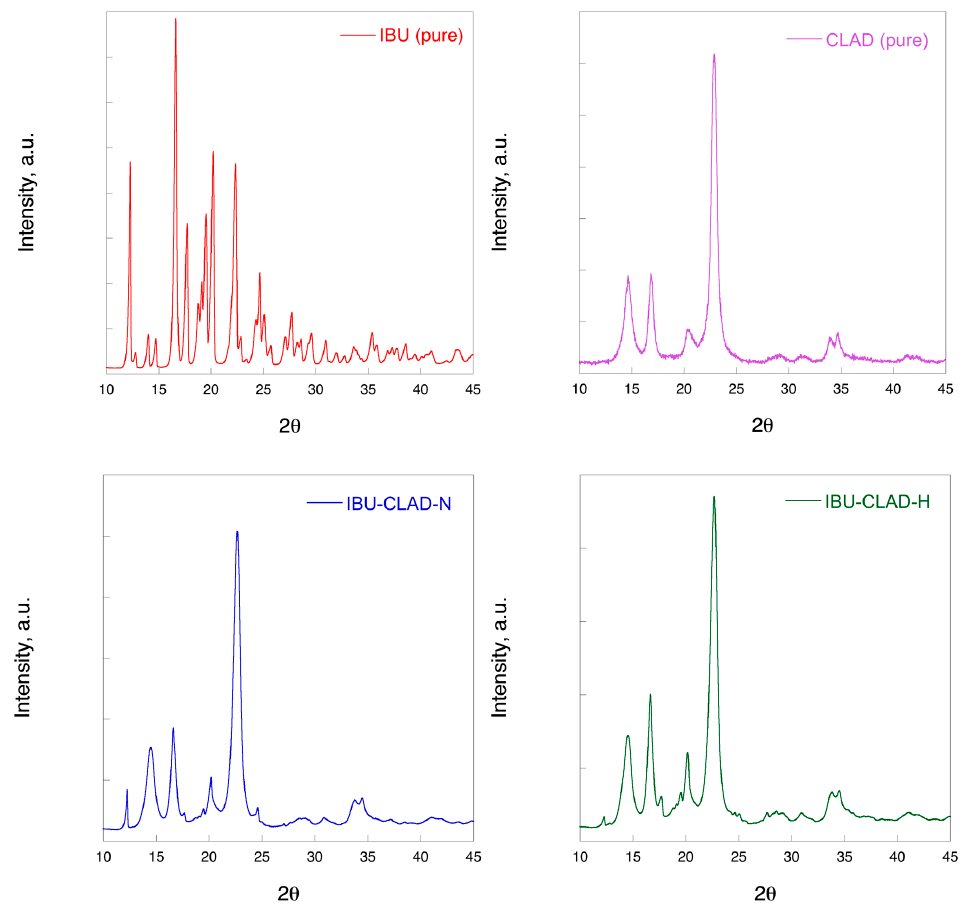
Figure 2. XRD profiles of IBU (pure), CLAD (pure), IBU-CLAD-N (non-heated), and IBU-CLAD heated